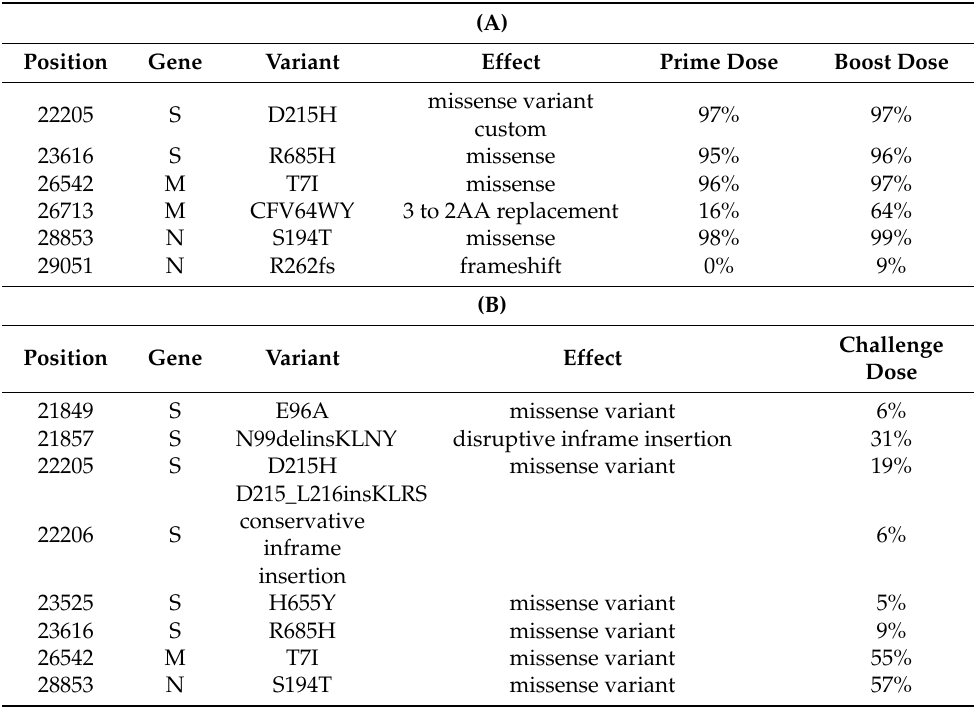
Table 1. NGS data on materials used in second challenge study. Prime and Boost ( A ). Challenge ( B ). D215H: Spike 215 also mutated in South African lineage (to a different amino acid). N679_R685del: Deletion removes furin cleavage site. R685H: Mutation in furin cleavage site. More variants and different percentages were observed in the challenge material compared to the vaccine prime